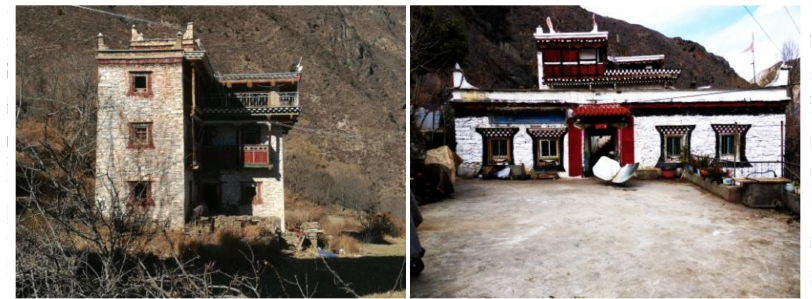
Figure 3. Typical Tibetan stone dwellings in Danba County.